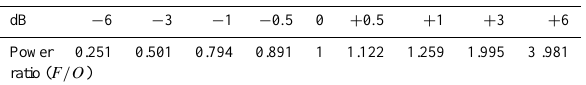
Table A1. Correspondence between the decibel scale and the power ratio. dB − 6 − 3 − 1 − 0 . 5 0 + 0 . 5 + 1 + 3 + 6